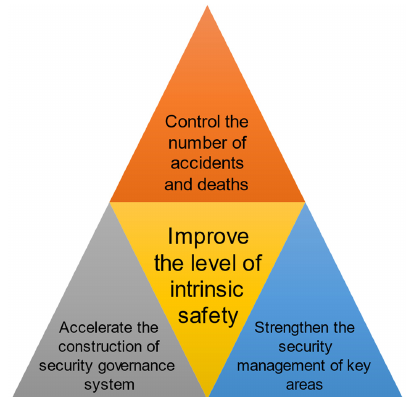
Figure 12. China’s hazardous chemical industry safety management development goals.